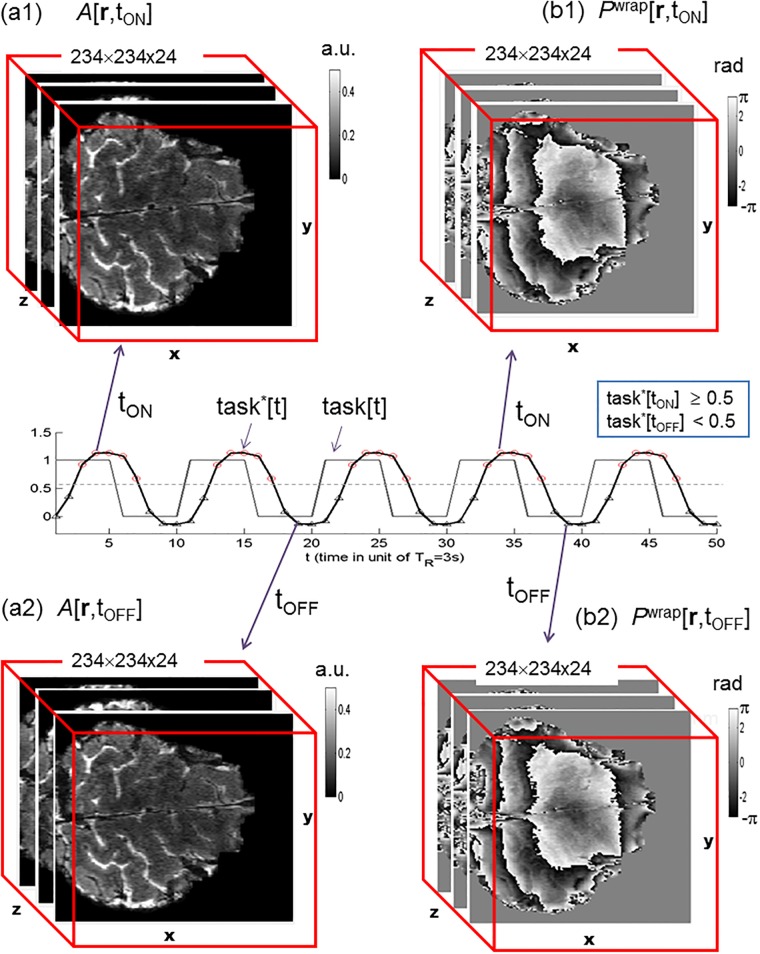
T2* magnitude and phase image acquisition under a task paradigm.The ON states are defined by task*[t] ≥ 0.5 and the OFF states by task*[t] < 0.5.